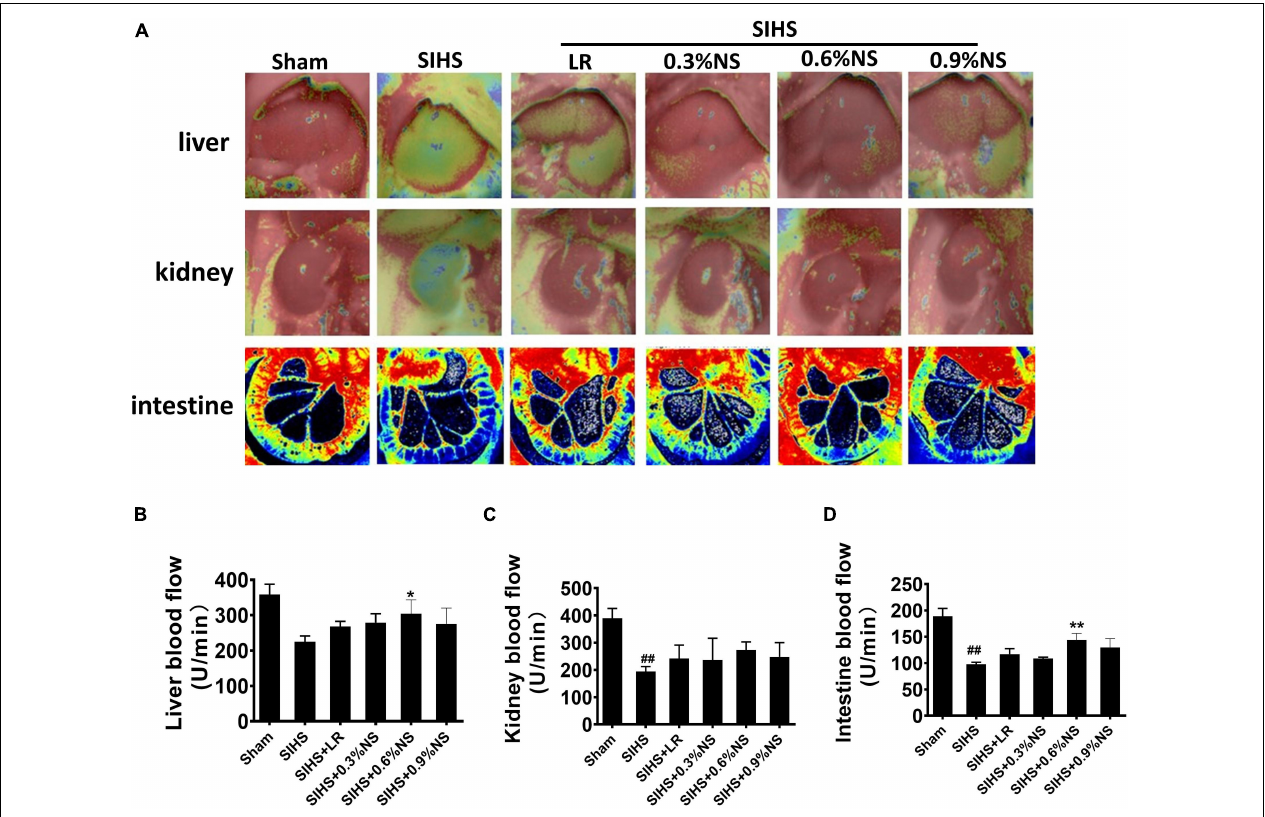
FIGURE 3 | Effects of different osmotic fluids on blood flow with seawater immersion in hemorrhagic shock rats ( n = 8/group). (A) Blood flow in the liver, kidney, and intestine with the Peri Cam PSI System. Blood flow in the liver, kidney, and intestine with laser Doppler imaging. (B) Statistical analysis of liver blood flow. (C) Statistical analysis of kidney blood flow. (D) Statistical analysis of intestinal blood flow. Sham, Sham-operated group; SIHS, seawater immersion combined with hemorrhagic shock; LR, lactated Ringer’s solution; NS, normal saline. * p < 0.05 and ** p < 0.01, compared with LR group. ## p < 0.01, compared with the Sham